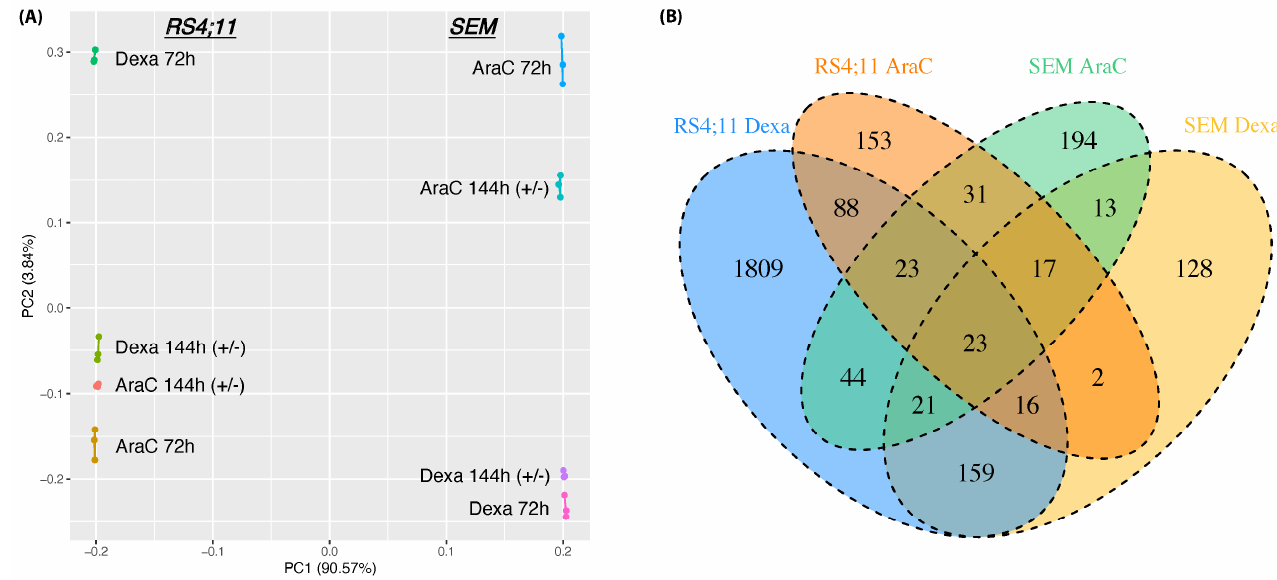
Figure 3. Dissimilarity of the transcriptional response of Dexa and AraC when applied to SEM and RS4;11. ( A ) PCA of whole transcriptome profiles of AraC and Dexa applications in the cell lines. ( B ) Venn diagram showing the differentially expressed genes (DEGs) of each drug treatment in each cell line. The experiments were carried out in biological triplicates.